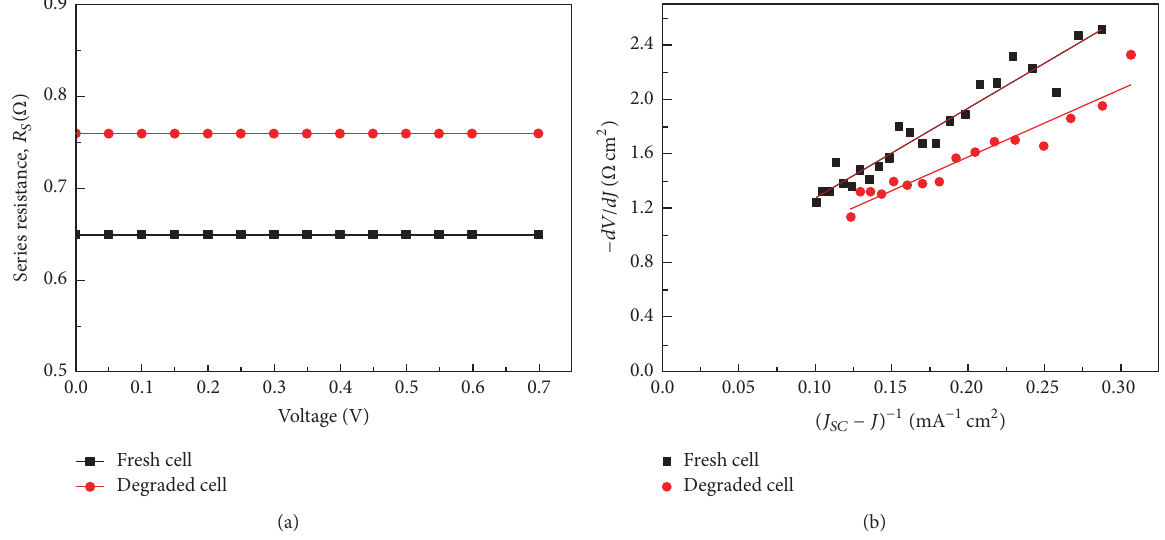
Figure 3: (a) 𝑅 𝑆 of both cells calculated by EIS. (b) 𝑅 𝑆 of both cells calculated by light J-V